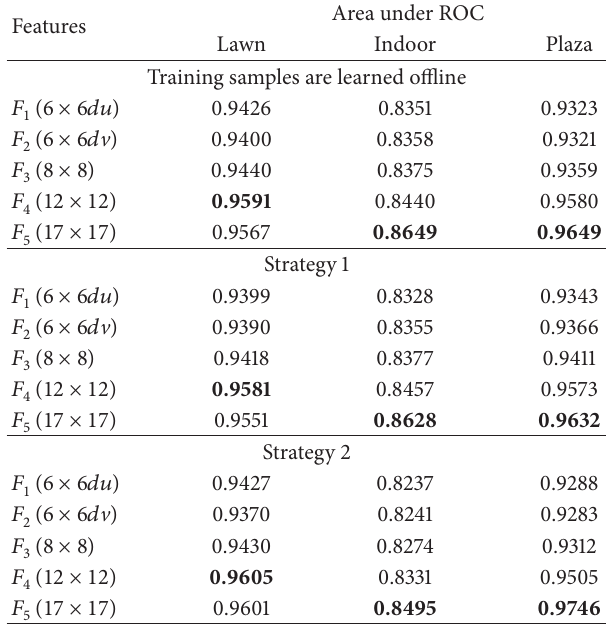
Table 2: AUC of abnormal event detection method of different features 𝐹 via original SVDD which learns training samples offline, Strategy 1 online one-class SVM, and Strategy 2 online one-class SVM. The biggest value of each method is shown in bold. Area under ROC Features Lawn